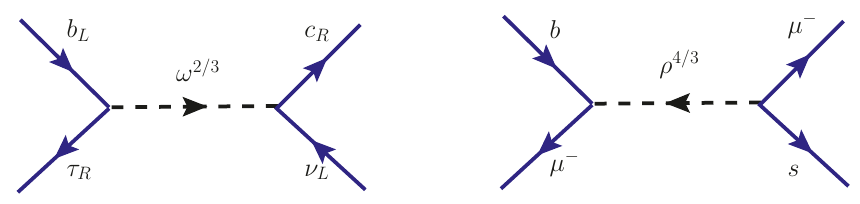
Figure 2 . Feynman diagrams for the dominant LQ contributions to the b → cτ − ¯ ν (left) and b → sµ − µ + (right)